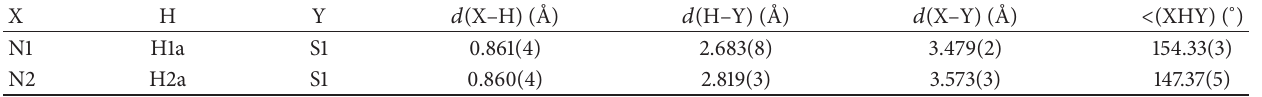
Table 2: Hydrogen bonding data for the title compound.